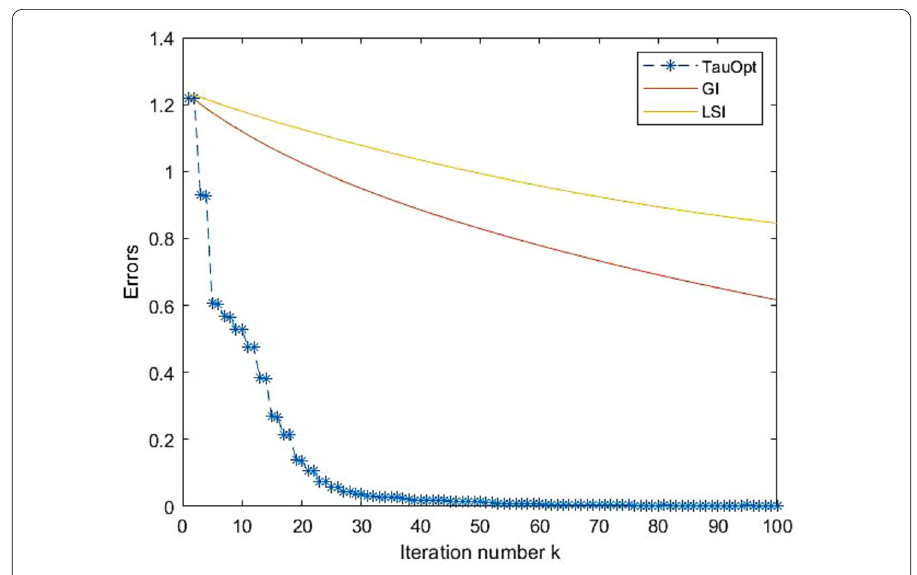
Figure 2 Errors for Ex. 5.2